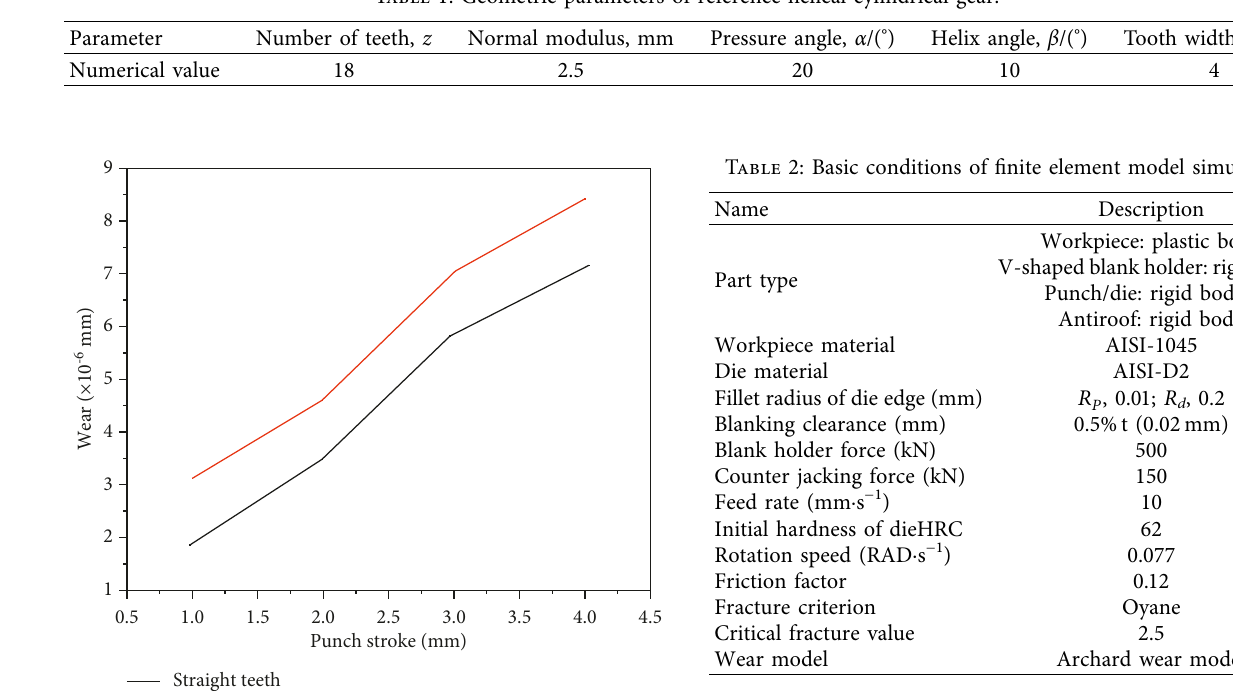
Table 1: Geometric parameters of reference helical cylindrical